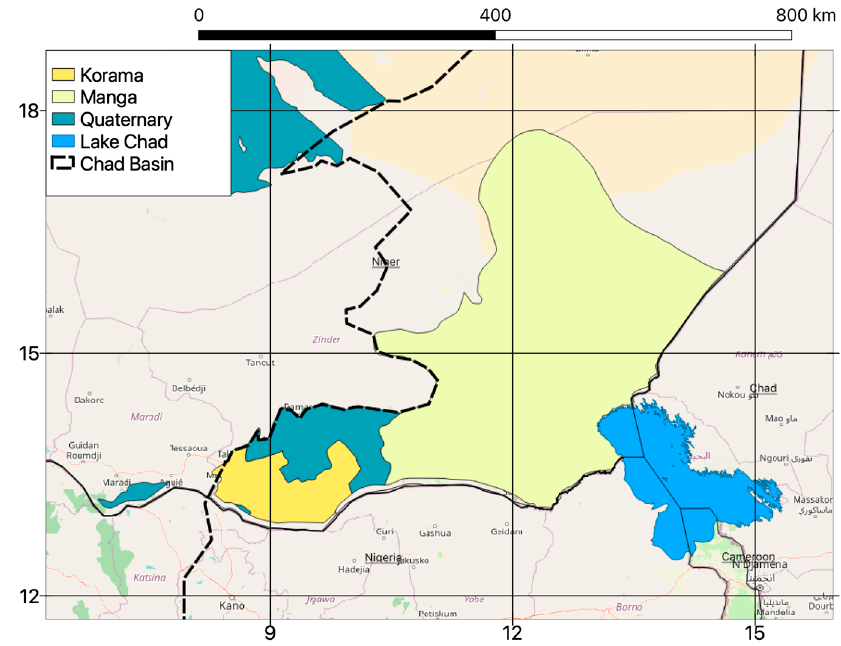
Figure 3. Principal shared aquifers in the Lake Chad